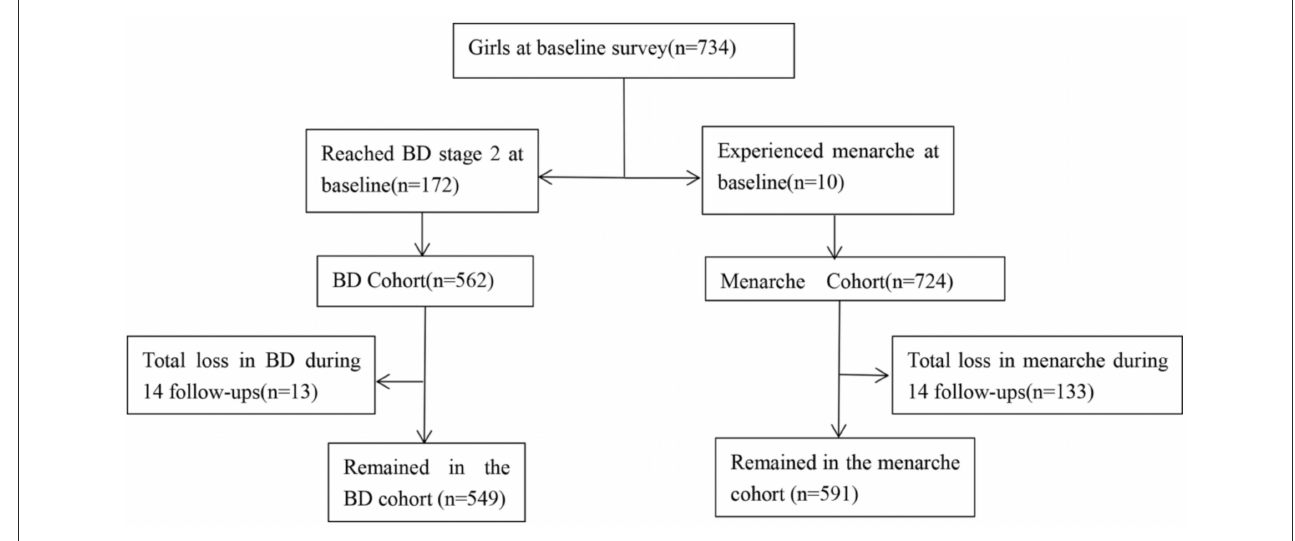
FIGURE1 Flowchart of the number of girls with different indicators of pubertal development. BD, Breast development.